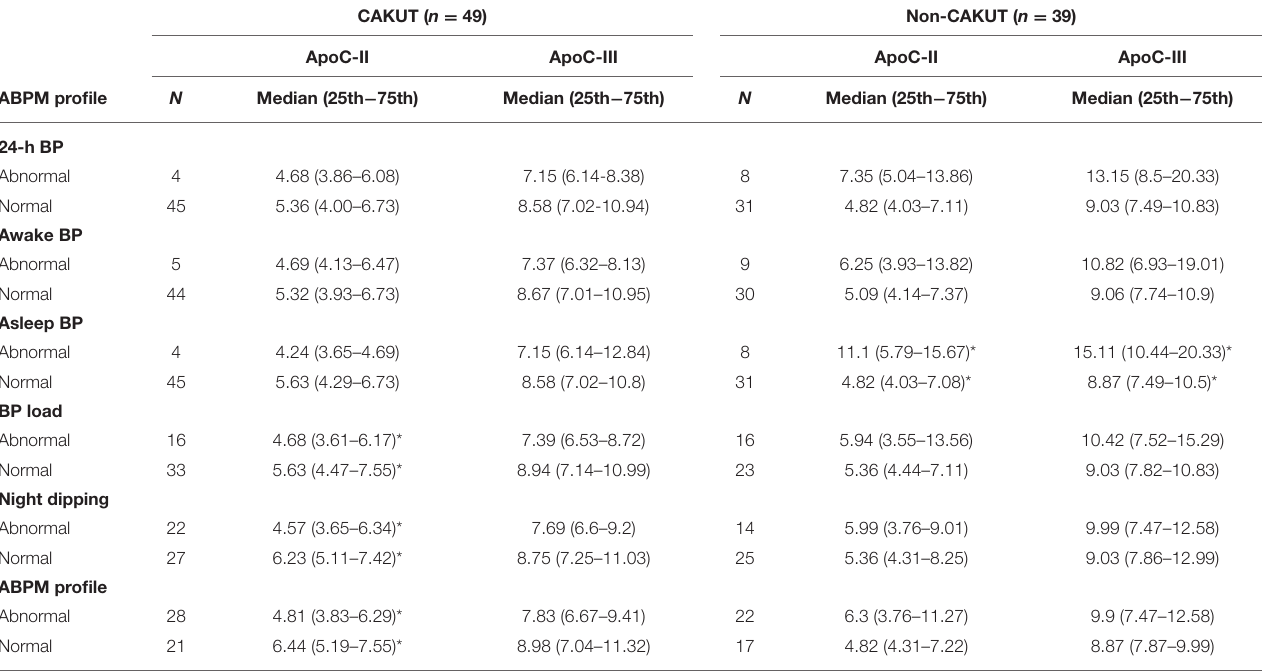
TABLE 5 | Plasma levels of apolipoprotein C-II and C-III vs. ABPM profile in CAKUT and non-CAKUT CKD children and adolescents. CAKUT ( n =